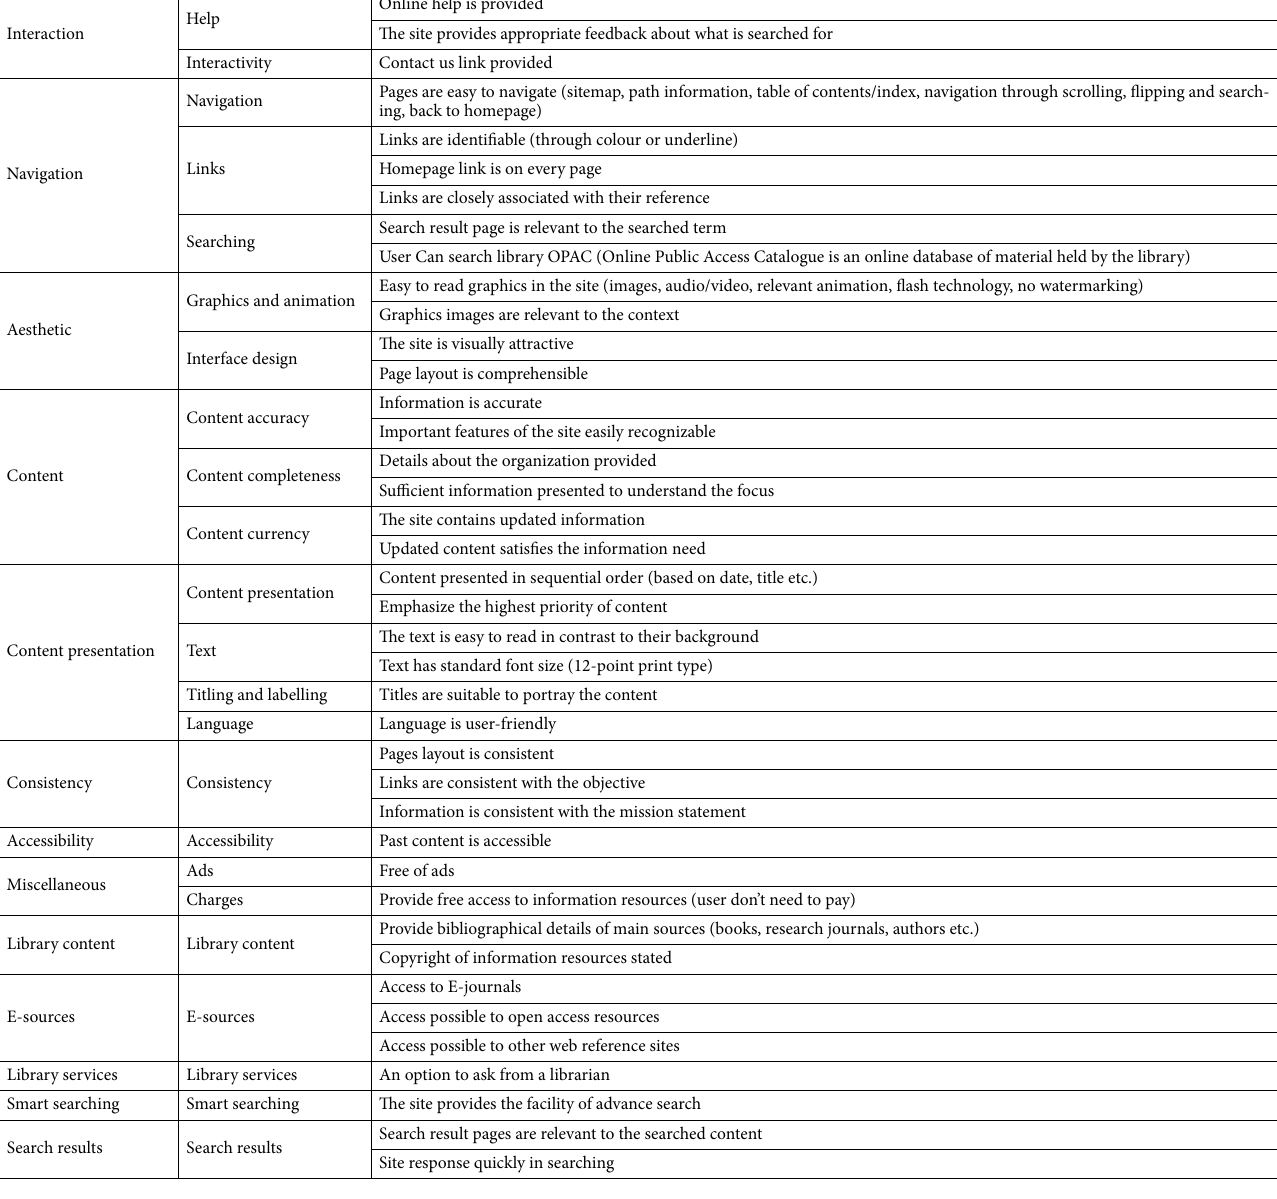
Table 4. Proposed usability evaluation